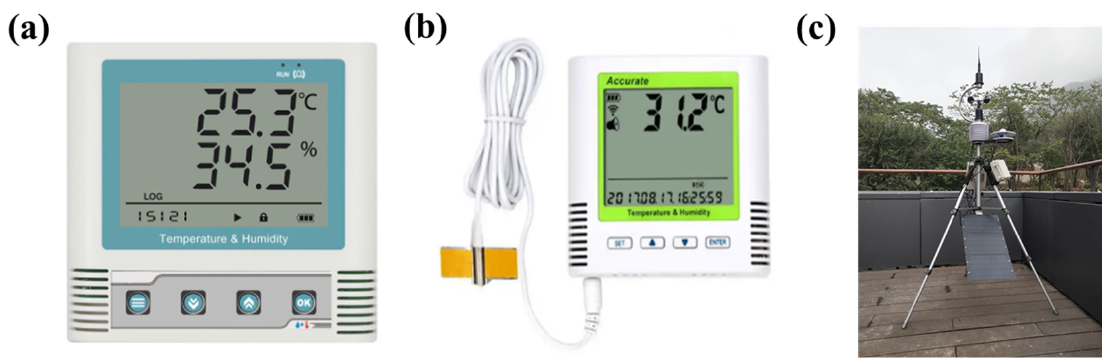
Figure 5. ( a ) USB temperature and humidity recorder; ( b ) SMD temperature recorder; ( c ) meteoro- logical station.